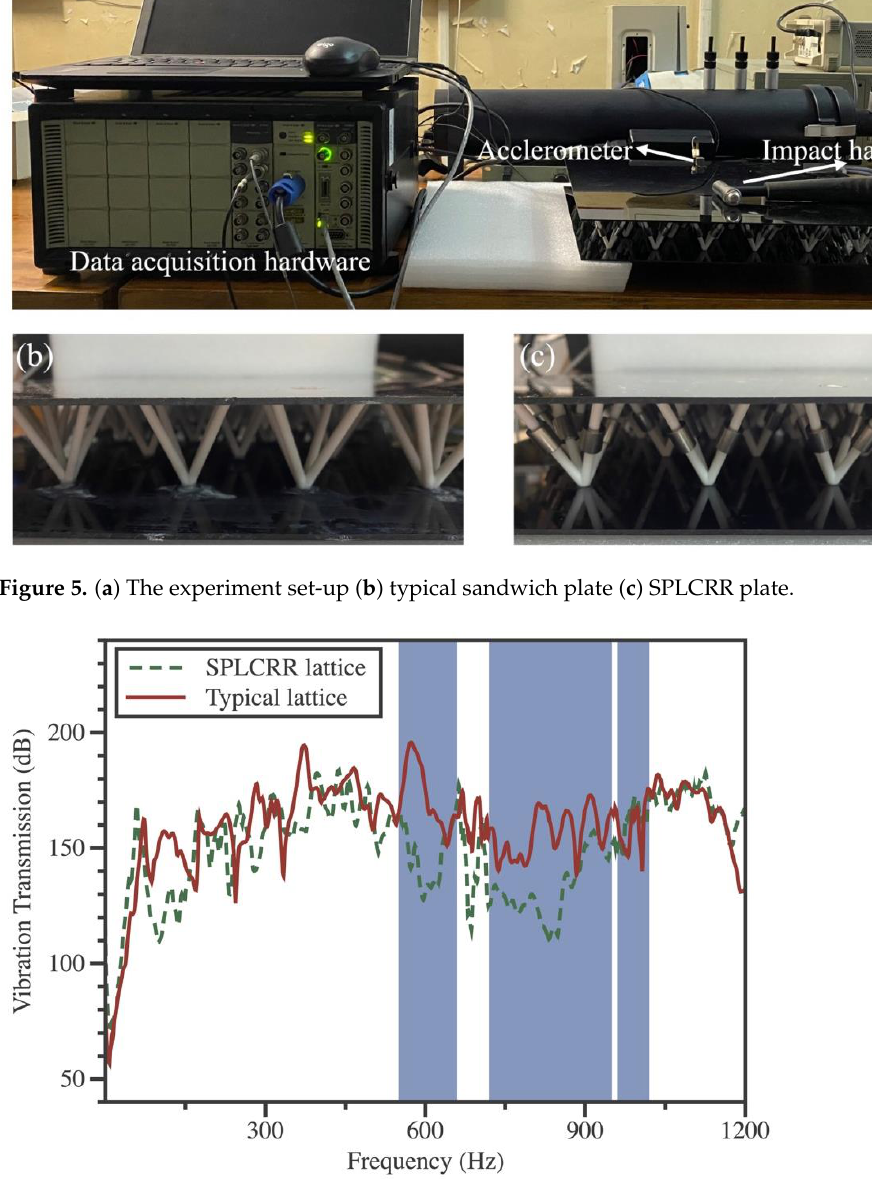
Figure 6. Comparison between the typical sandwich plate and SPLCRR plate for vibration transmis- sion spectra.